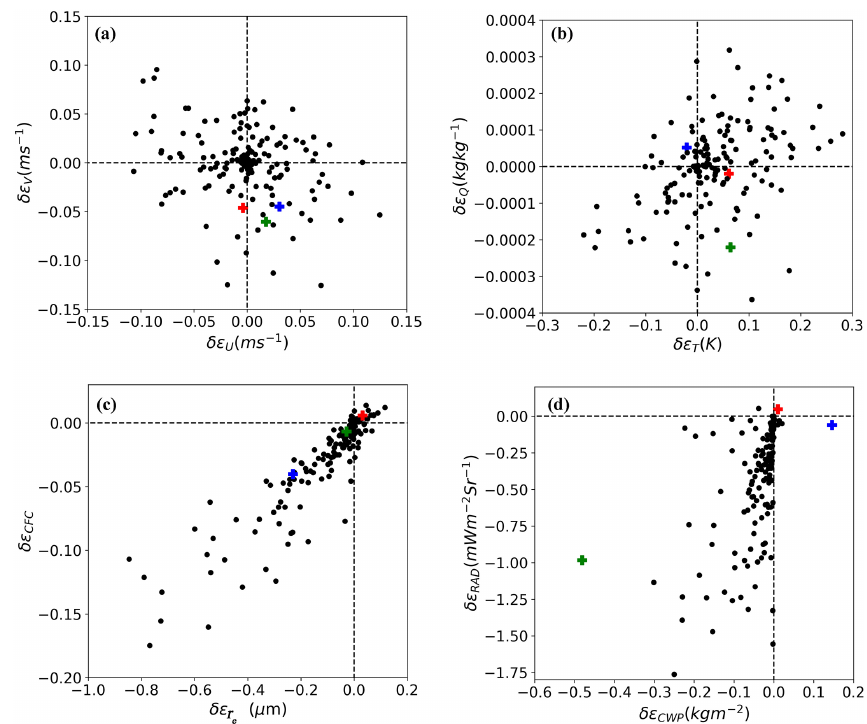
Figure 3. Differences in the mean profile error (MPE) between the ensemble mean of the first guess and the analysis, denoted as δε X = X MPE , pos − X MPE , pri , where X denotes a state variable or a diagnosed parameter, and pos and pri the analysis and first guess, respectively. The variables include (a) the x - and y -wind components ( U and V ), (b) the perturbation potential temperature ( T ) and water vapor mixing ratio ( Q ), (c) the cloud fraction (CFC) and effective radius ( r e ), and the (d) cloud water path (CWP) and radiance (RAD). The plus signs in green, blue, and red correspond to points 1, 2, and 3, respectively, in Fig. 1.